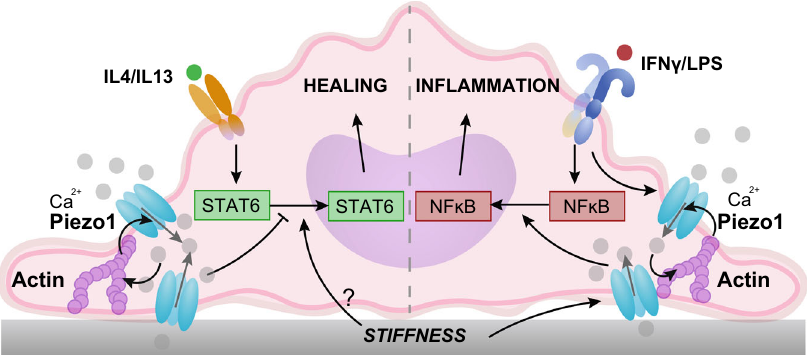
Fig. 6 Stiffness-dependent modulation of Piezo1 activity modulates macrophage activation. Activation of Piezo1 by IFN γ /LPS on stiff substrates promotes actin polymerization, which enhances channel mediated Ca 2 + in fl ux. Positive regulation between actin and Piezo1 enhances in fl ammation through activation of the transcription factor, NF κ B and upregulation of in fl ammatory markers, including iNOS, TNF α and IL6. Ca 2 + in fl ux through Piezo1 channels on stiff substrates inhibits the activation of the transcription factor STAT6 and expression of healing markers, such as ARG1. Other stiffness mediated and Piezo1 independent mechanisms likely upregulate STAT6 activation